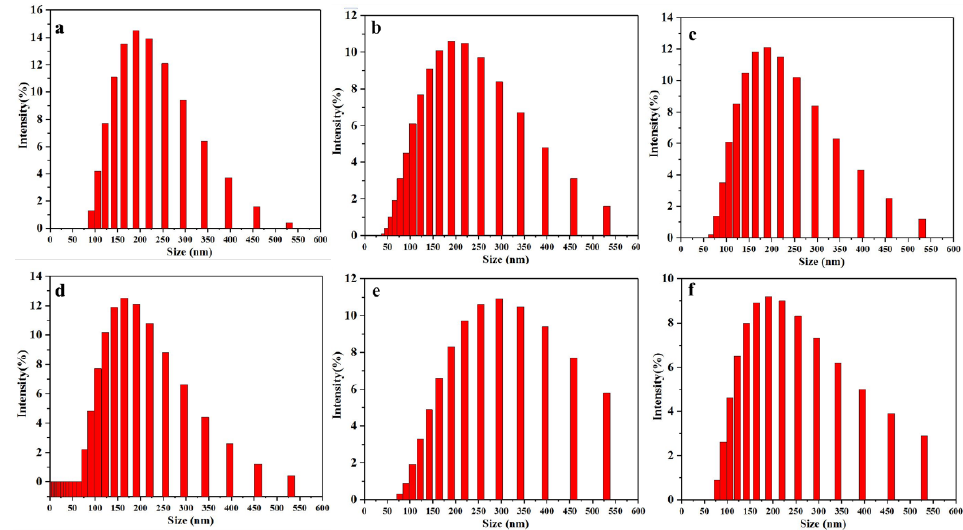
Figure 3. The particle sizes and distributions of WPUR1 ( a ), WPUR3 ( b ), WPUR5 ( c ), WPUR6 ( d ), WPUR9 ( e ) and WPUR10 ( f ), respectively.